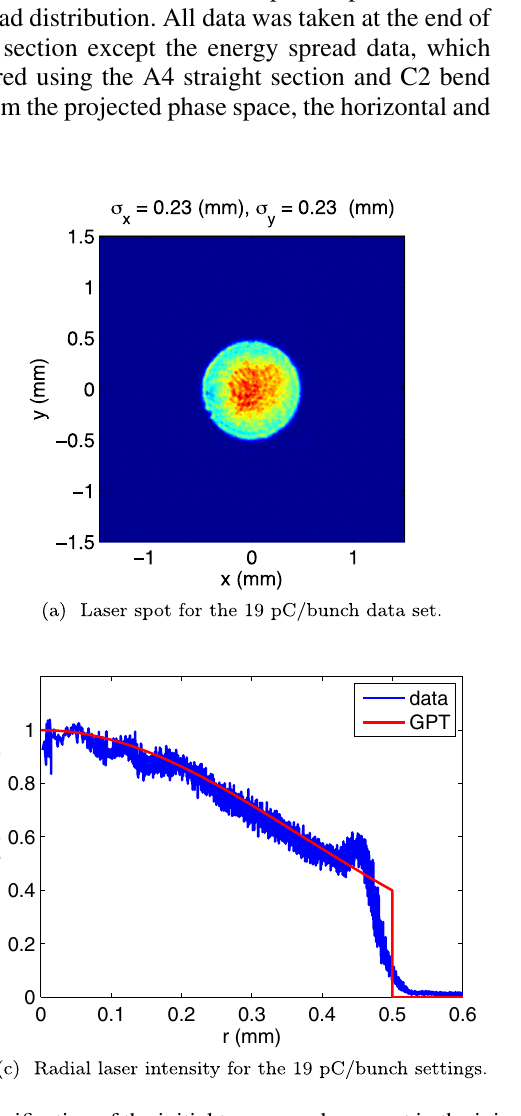
FIG. 12. Verification of the initial transverse laser spot in the injector and GPT input file: (a) and (b) show the measured laser spot on a CCD camera as they would appear on the cathode. The uncertainty in the rms spot sizes is (a) (cid:1) 0 : 01 mm and (b) (cid:1) 0 : 02 mm . The plots in (c) and (d) show the corresponding measured radial laser intensity (blue) and matching truncated Gaussian (red) used in